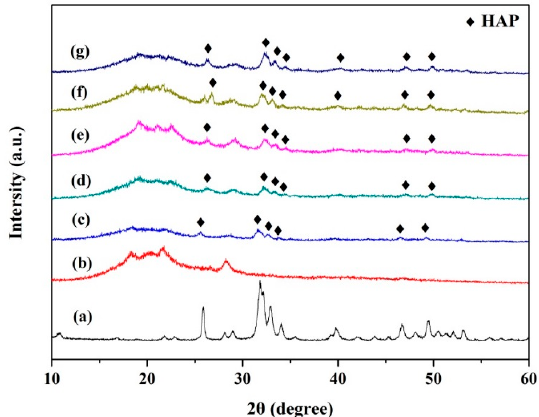
Figure 3. X-ray diffraction (XRD) patterns of ( a ) the HAP powder; ( b ) the PEEK/PGA scaffold; ( c ) the PEEK/PGA-5 wt % HAP scaffold; ( d ) the PEEK/PGA-7.5 wt % HAP scaffold; ( e ) the PEEK/PGA-10 wt % HAP scaffold; ( f ) the PEEK/PGA-12.5 wt % HAP scaffold and ( g ) the PEEK/PGA-15 wt %.